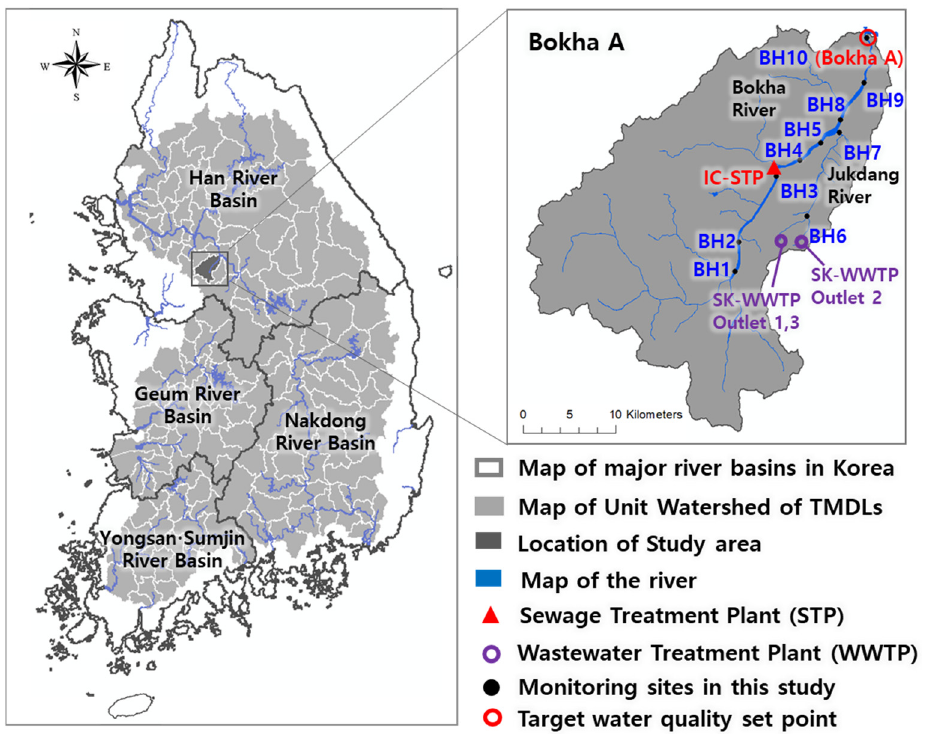
Figure 1. Study area. Table 2. Surveyed public STPs and WWTPs in the study area.